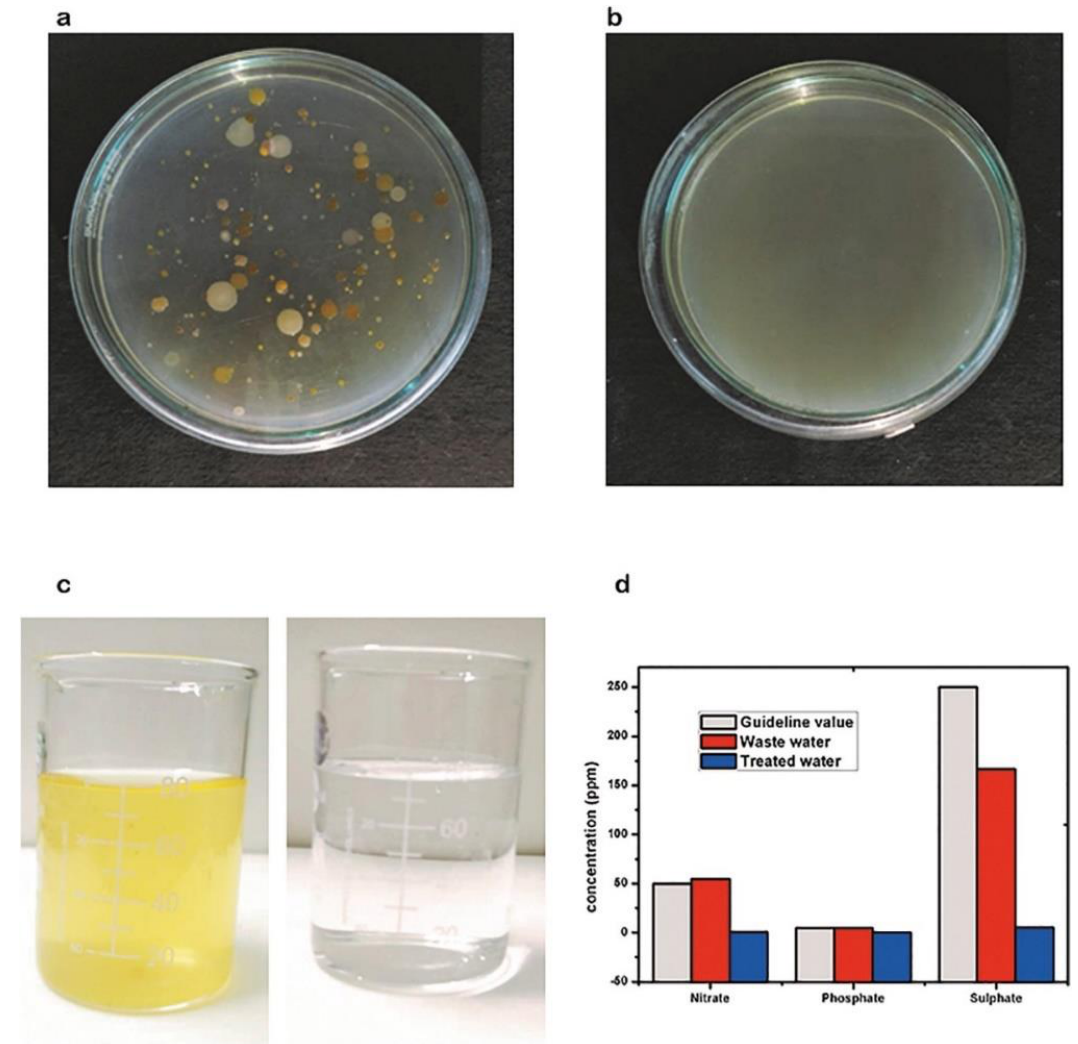
Figure 11. Application of the plasmonic-modified cotton-based membrane in wastewater treatment: ( a ) bacterial colonies in the wastewater; ( b ) nonexistence of bacterial colonies in the water treated with the designed membrane; ( c ) visual appearance of the wastewater and the treated water; and ( d ) performance of the designed membrane in the removal of nitrate, phosphate, and sulfate ions. Reprinted with permission from [138]. Copyright © 2019, Elsevier.